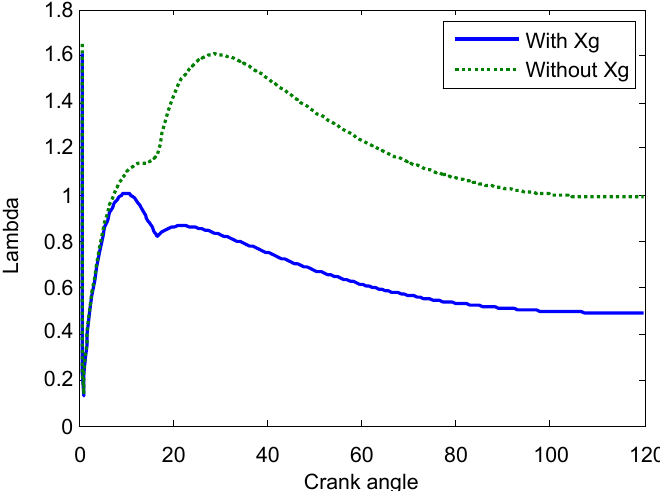
Figure 5. Curves of the value of λ with and without χ g during combustion.